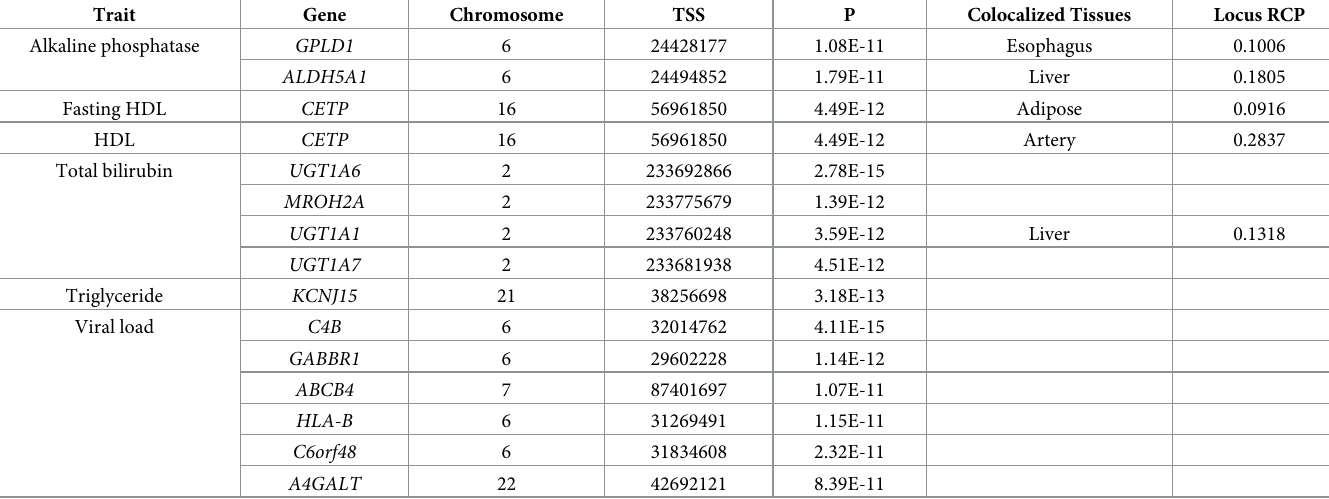
Table 3. Replicated associations related to HIV baseline laboratory values identified by TSA-TWAS.